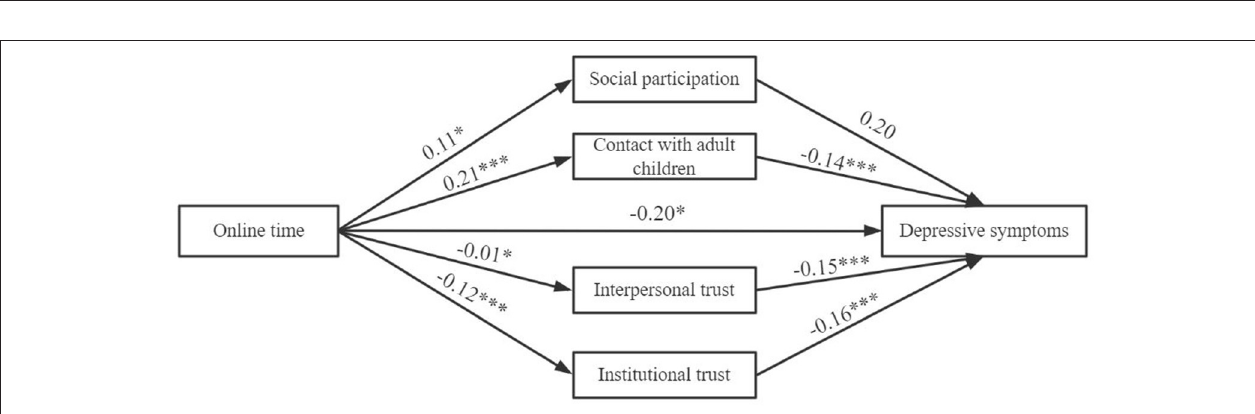
Frontiers in Psychology |